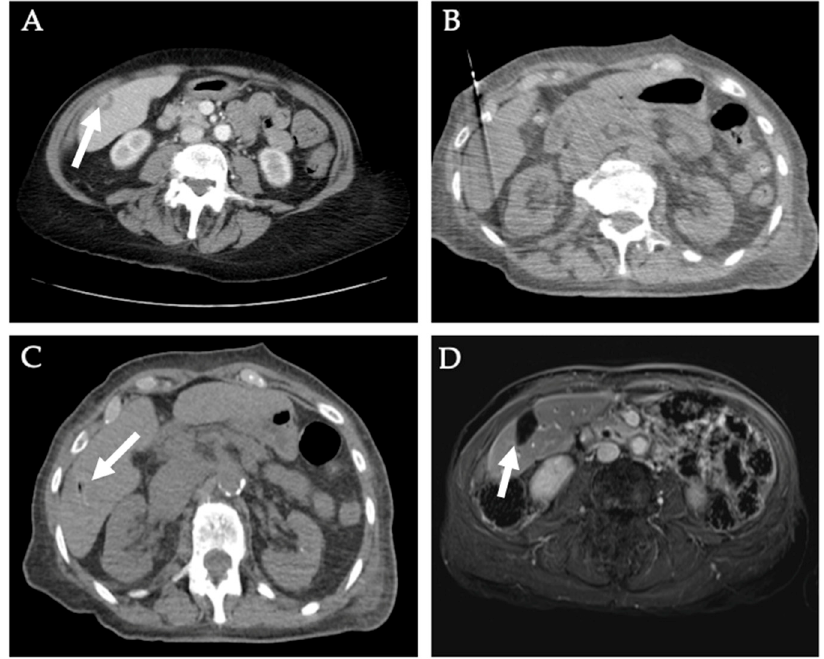
Figure 8. Microwave ablation of hepatic metastatic leiomyosarcoma . A 73-year-old female patient with a 2.1 × 1.5 cm sub-capsular metastatic leiomyosarcoma (white arrow) in segment V ( A ) on CT scan. The patient underwent chemotherapy followed by MWA. ( B ) Probe placement and ( C ) immediate post-ablation image of the right hepatic lobe lesion. The patient then underwent proton therapy of inferior vena cava mass and left hepatic metastasis. ( D ) Six-month follow-up MRI shows complete